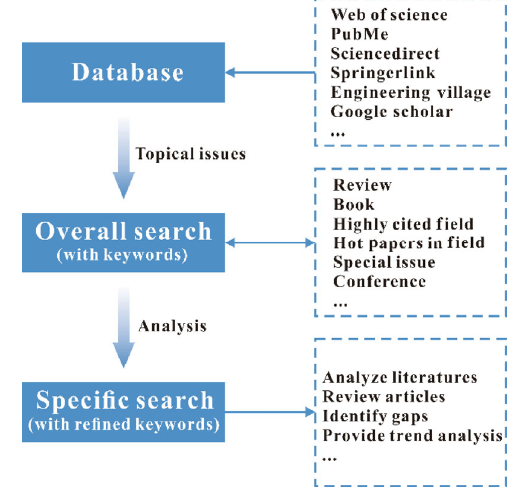
Fig. 18 Overall search strategy.